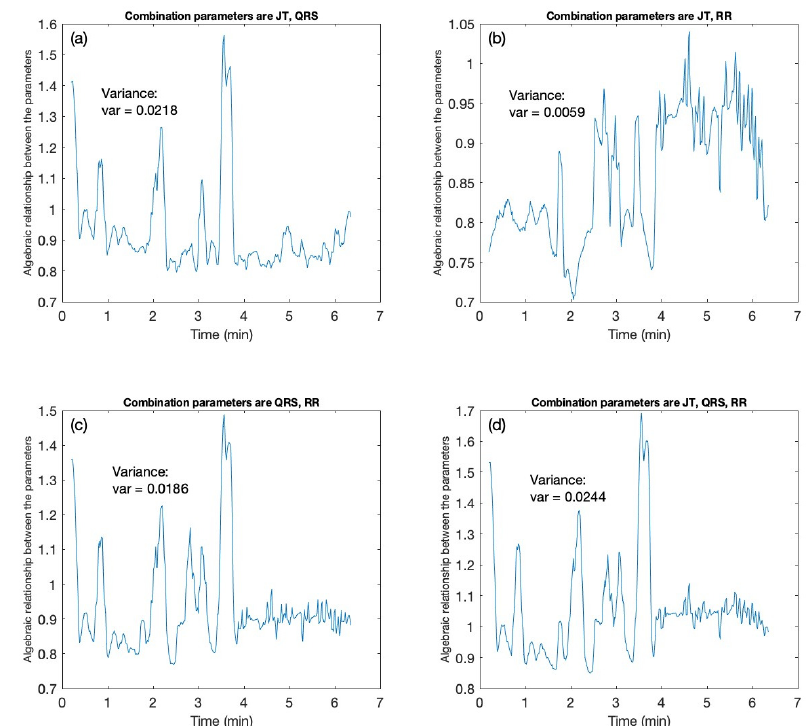
Figure 3. The sensitivity of 3-by-3 matrices vs 2-by-2 matrices is demonstrated for one of the candidates. The x -axis denotes the time in minutes. The y -axis demonstrates the algebraic relationship for the 2-by-2 ( a – c ) and 3-by-3 ( d ) matrix combination for the cardiac intervals JT, QRS, RR. ( a ) The 2-by-2 matrix algebraic relation is computed for the combination of cardiac intervals JT, QRS. ( b ) The 2-by-2 matrix algebraic relation is computed for the combination of cardiac intervals JT, RR. ( c ) The 2-by-2 matrix algebraic relationship is computed for the cardiac intervals QRS, RR. ( d ) The 3-by-3 matrix algebraic relationship is computed for the combination of cardiac intervals JT, QRS, RR .